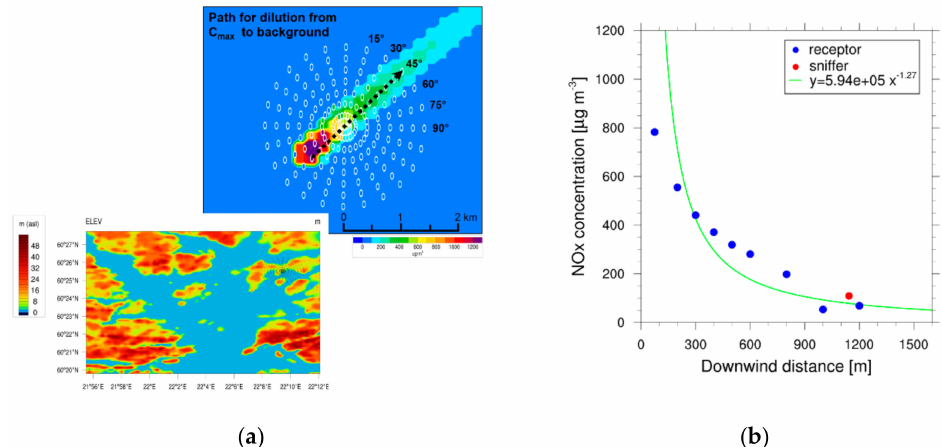
Figure 3. Dilution of the ground concentrations of NO X near the ground level in the ship plume for ship event J_20100811. ( a ) In the upper panel, the circular receptor grid (shown as white circles filled with the color corresponding to the range of concentrations) was used to extract concentration data for the modeled dilution curve. The concentrations were evaluated along a visually determined plume centerline, with increasing distance from the maximum concentration at the ground level to the urban background concentration (shown by the black arrow). The lower panel shows the elevation map of the Turku domain. ( b ) Power-law fit (green line) to the modeled concentrations at receptors (blue dots) in the plume, together with the measured peak 1-min averaged concentration at Sni ff er (red dot). Background concentrations were subtracted from the NO X concentration